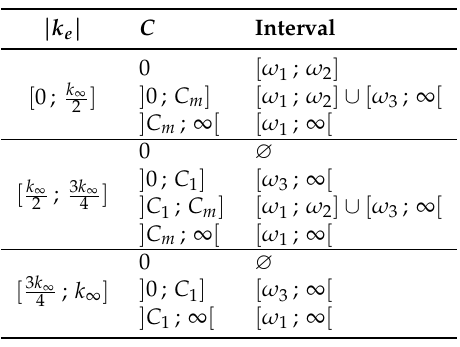
Table 1. Stable speed